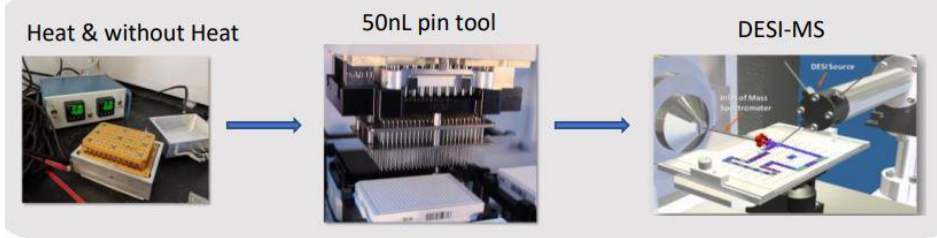
Figure 5. General workflow for the high-throughput DESI-MS based experiments; Reprinted with permission from ref. [75]. Copyright 2020 American Chemical Society.